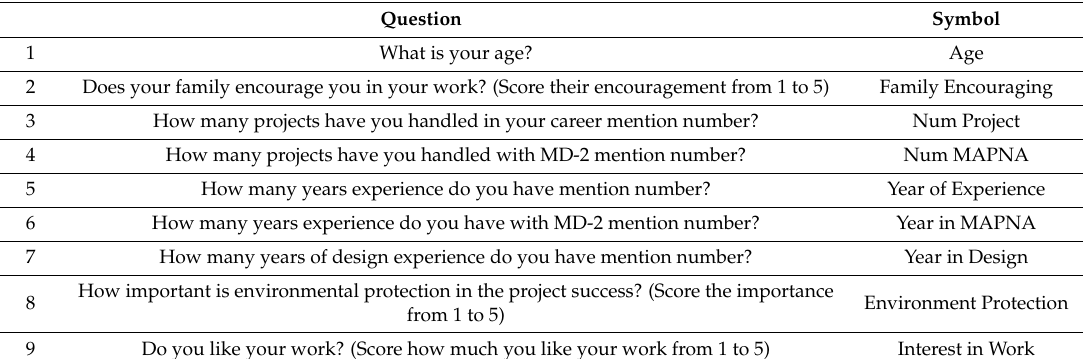
Table 1. Questions and their symbols concerning the engineers’ demographic data.